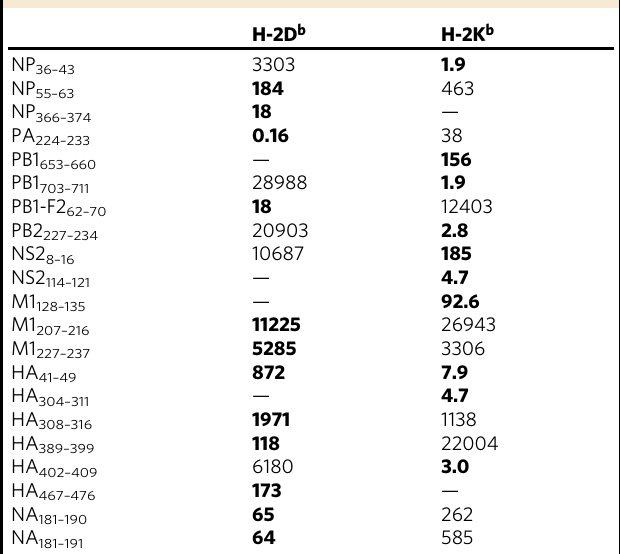
Table 2 Measured IC 50 (nM) of each